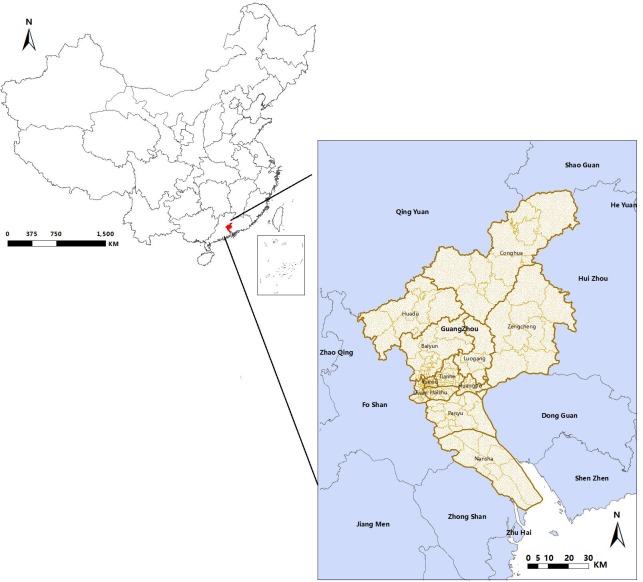
Location of Guangzhou city in Guangdong province, China.Fig 1 was generated by ArcGIS 10.0 (Environmental Systems Research Institute, RedLands, California, U.S.A).